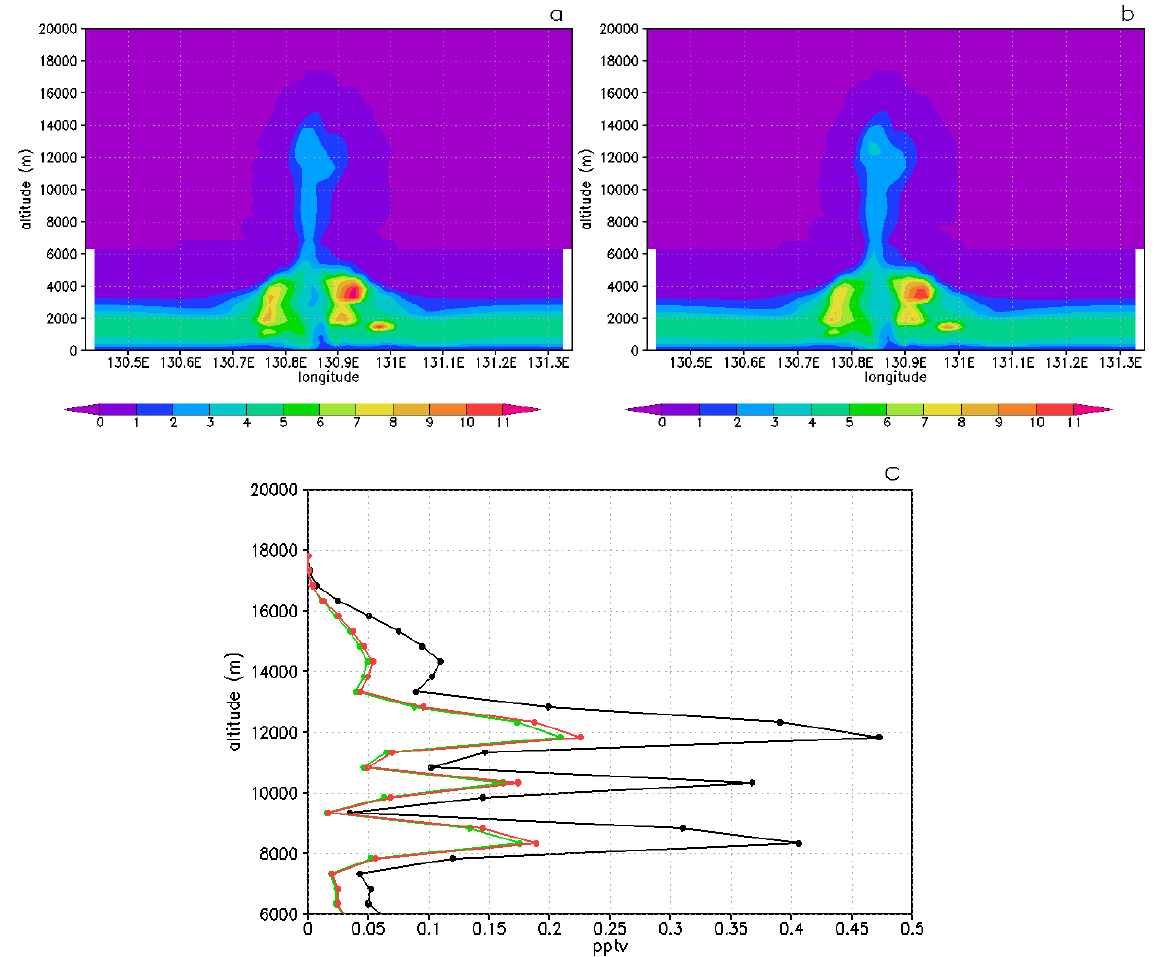
Fig. 14. Longitude-altitude cross-section at the latitude − 12.4 ◦ S from the PERT1 simulation at t 0 + 30mn of (a) Br x (Br+BrO+HOBr+2 · Br2) for cloud pH = 5 with no chlorine chemistry, (b) Br x (Br+BrO+HOBr+2 · Br2+BrCl) for cloud pH = 5 with Figure 14: Longitude-altitude cross-section at the latitude -12°.4 S from the PERT1 simulation at chlorine chemistry, and (c) mean profile averaged on the horizontal of Br x at the end of the convective event ( t 0 + 110mn) for cloud pH = 4 with no chlorine chemistry black), Br x for cloud pH = 5 with no chlorine chemistry (green), Br x with chlorine chemistry for cloud t +30 mn of a) Br (Br+BrO+HOBr+2*Br2) for cloud pH = 5 with no chlorine chemistry, b) Br 0 x x pH = 5 (Br+BrO+HOBr+2.*Br2+BrCl) for cloud pH = 5 with chlorine chemistry, and c) mean profile averaged on the horizontal of Br at the end of the convective event (t +110 mn) for cloud pH = 4 x 0 with no chlorine chemistry black), Br for cloud pH = 5 with no chlorine chemistry (green), Br x x with chlorine chemistry for cloud pH = 5 (red).